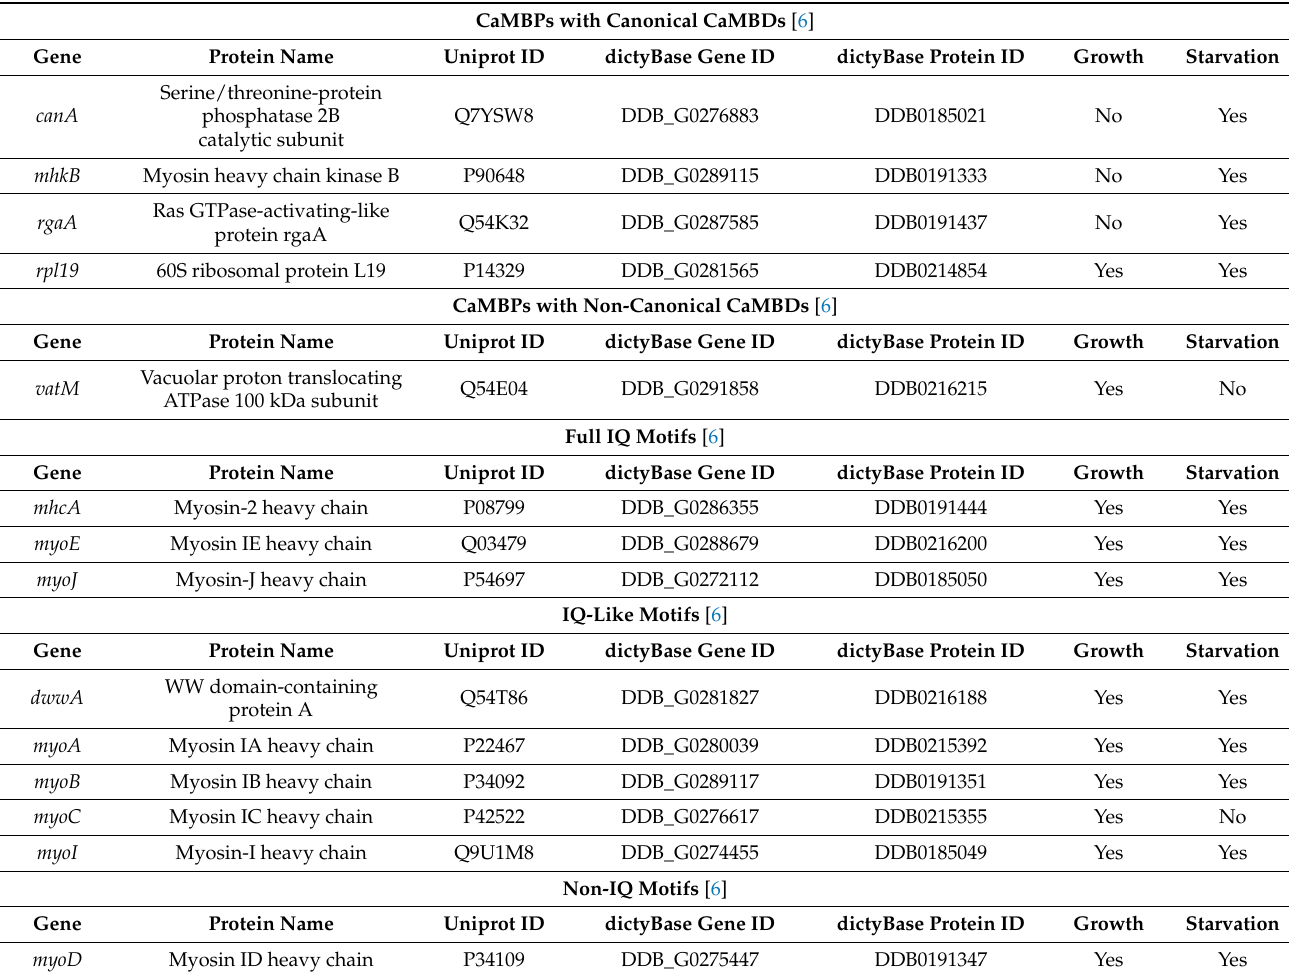
Table 2. List of proteins revealed in calmodulin (CaM) immunoprecipitation (IP) fractions with identified CaM-binding domains